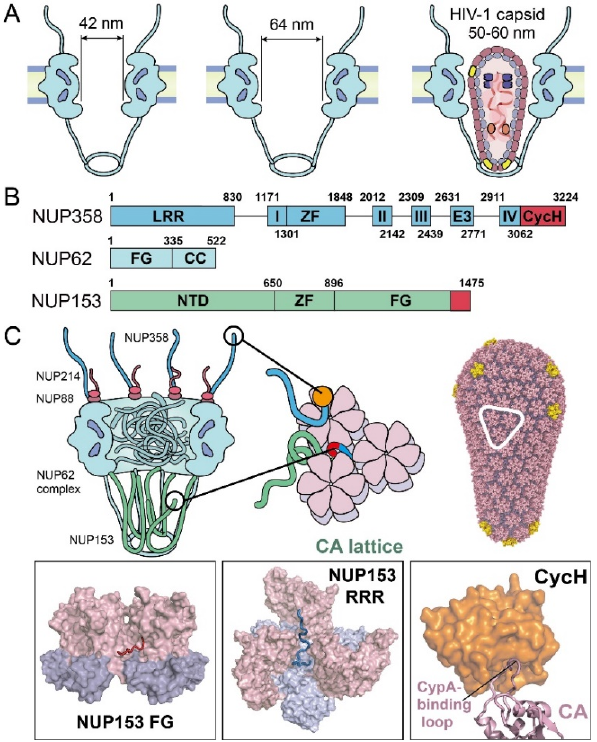
Figure 3. NPC components known to affect nuclear import of the HIV ‐ 1 core. ( A ) Schematics of the diameters of the NPC central channel and the size of HIV ‐ 1 capsid. ( B ) Domain organization of the major capsid ‐ interacting NUPs, including NUP358, NUP153, and NUP62. Known CA ‐ binding fragments are colored in red. Domain labels are as follows: LRR—leucine ‐ rich region; roman numerals I–IV—Ran binding domains I–IV; ZF—zinc finger; E3—E3 ligase domain;